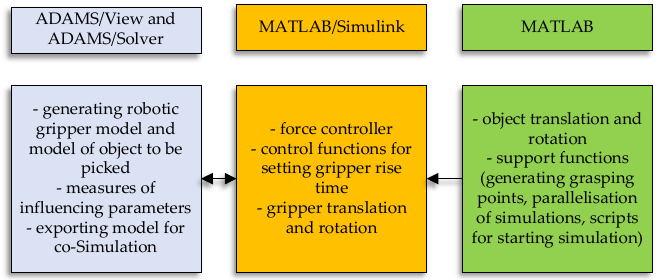
Figure 1. Simulation model components. Source: own.